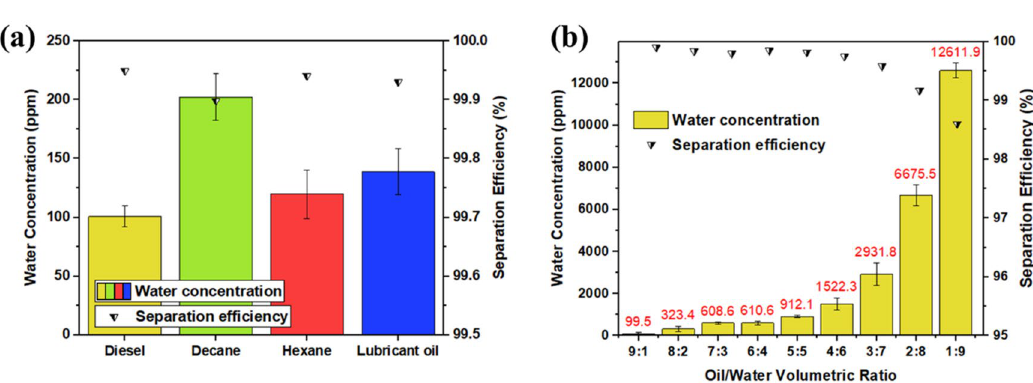
Figure 5. Water concentration of separated oil and separation efficiency of the superhydrophobic GMF membrane for ( a ) various light oil/water mixtures and ( b ) different volumetric ratios of oil/water